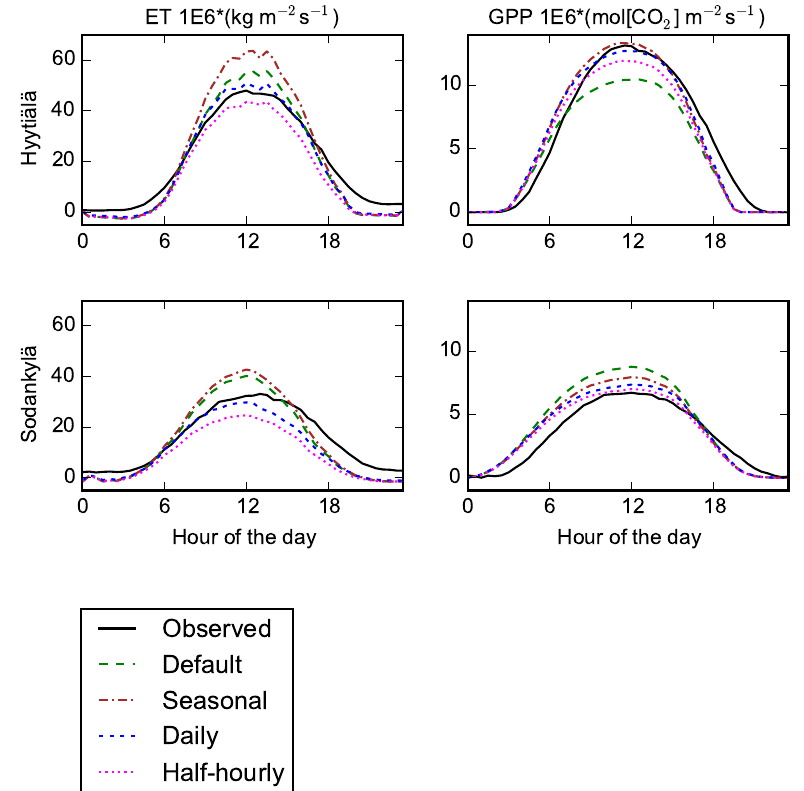
Figure 4. Average diurnal cycle from May to September for the validation